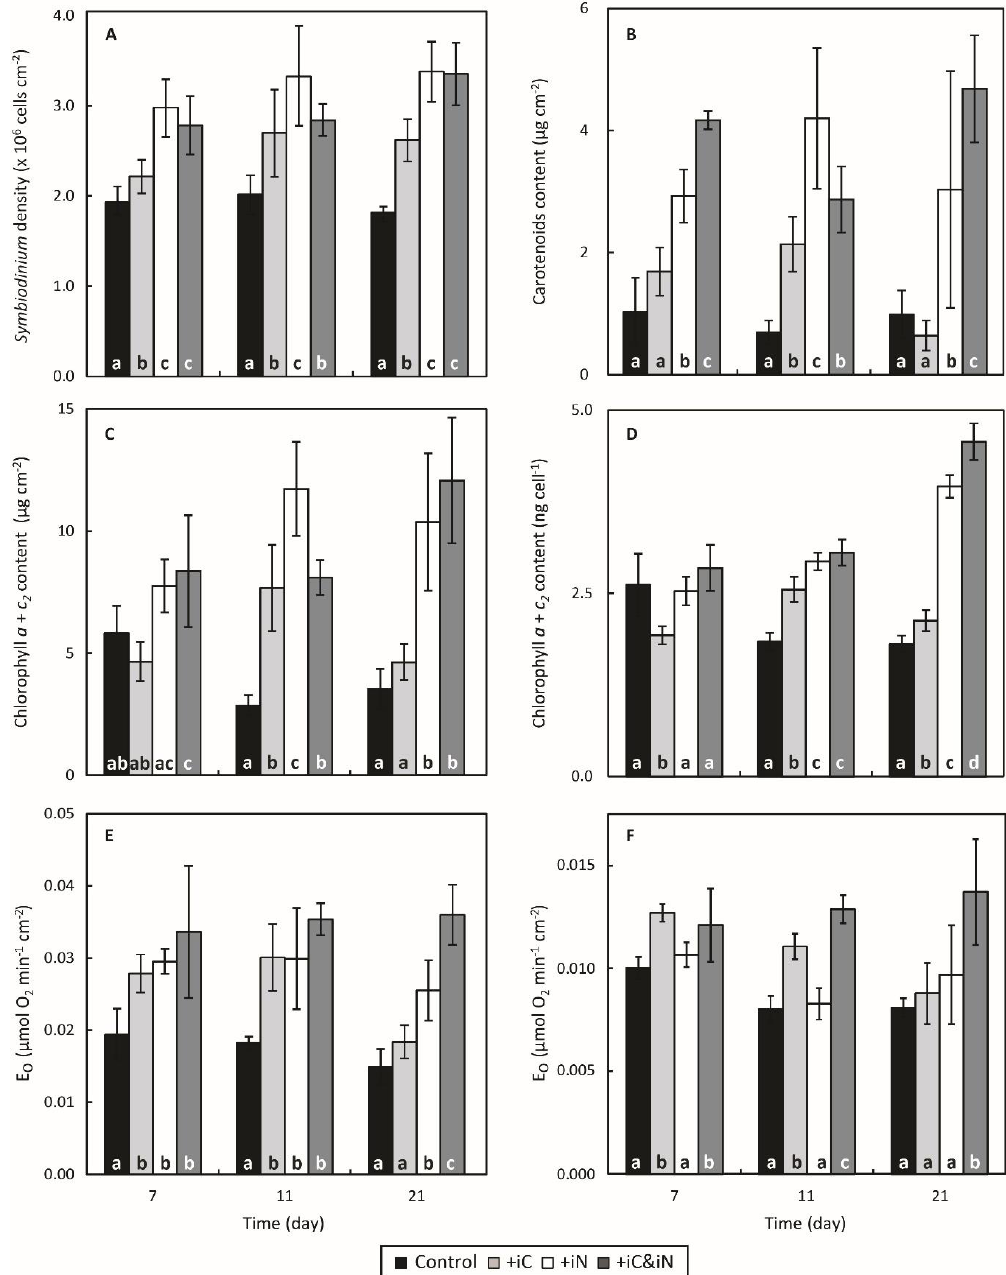
Figure 2. Evolution of the physiological parameters of the coral S. pistillata exposed for 3 weeks to natural seawater (control) and to seawater enriched with 6 mM HCO 3− (+iC) or 4 µM NH 4+ (+iN) or both (+iC & iN). ( A ) Symbiodinium densities (× 10 6 cells −1 cm −2 ), ( B ) total carotenoids concentrations (peridinin + xanthophylls + β-carotene; µg cm −2 ), ( C ) total chlorophylls concentrations ( a + c 2 ; µg cm −2 ), ( D ) Total chlorophylls cellular concentrations ( a+c 2 ; ng cell −1 ), ( E ) gross photosynthesis of the holobiont (gross O 2 evolution by PSII (E O ); µmol O 2 min −1 cm −2 ) measured at 600 µmol photons m −2 s −1 , ( F ) gross photosynthesis of the symbionts (fmol O 2 min −1 cell −2 ). Data are presented as mean ± SD ( n = 6). Different letters indicate statistically significant differences between each treatment for one time point ( P < 0.05).